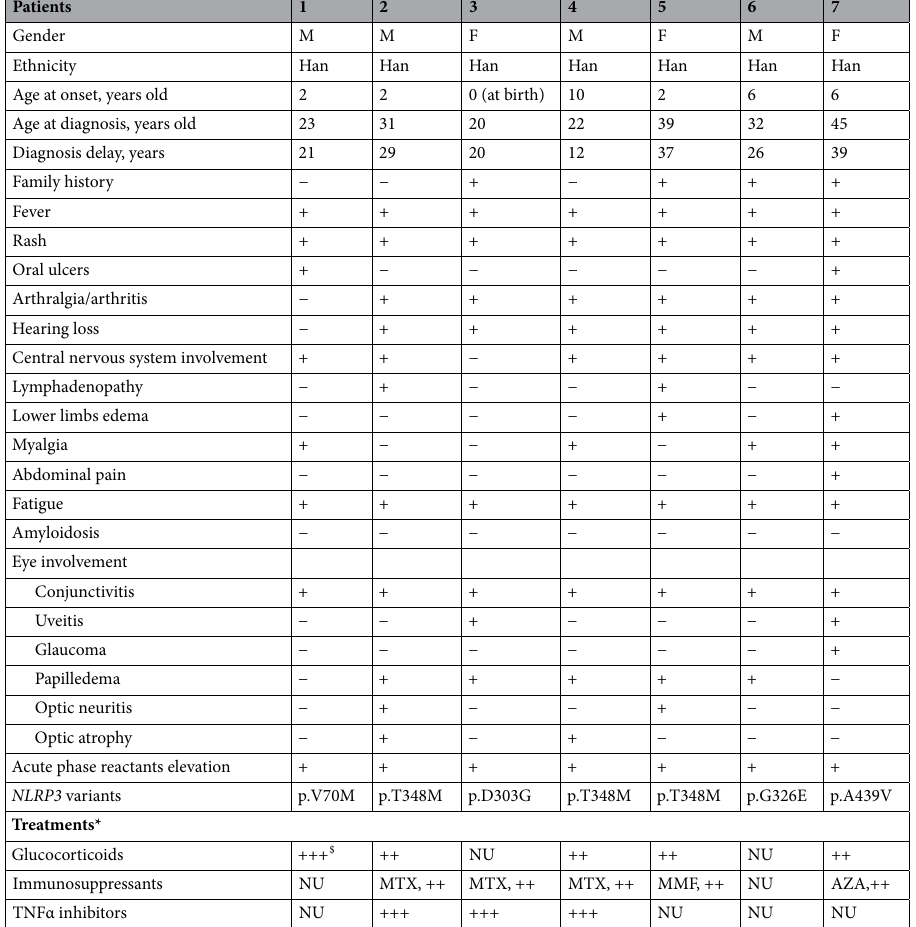
Table 1. Clinical and genetic features of 7 NLRP3 -AID patients with ocular involvement. MTX methotrexate, MMF mycophenolate mofetil, AZA azathioprine, NU not used. *−poor response; +mild response; ++moderate response; +++good response. $ Oral treatment only during